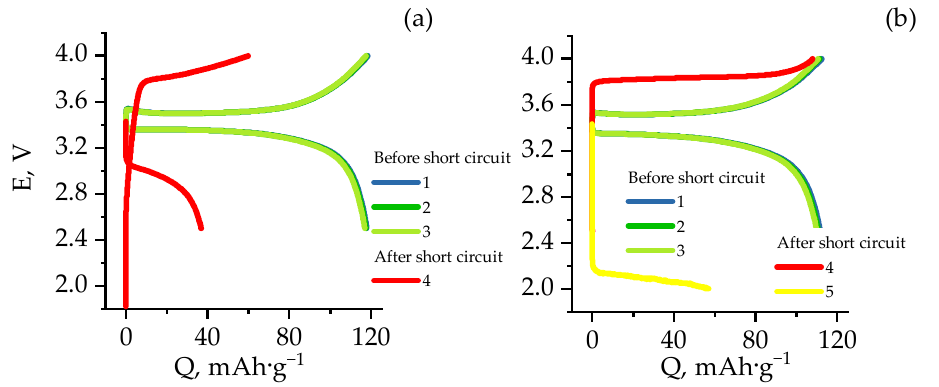
Figure 4. Charge-discharge curves with 0.5 C current before and after short circuit for Al/LFP ( a ) and Al/poly/LFP-based ( b ) coin cells.